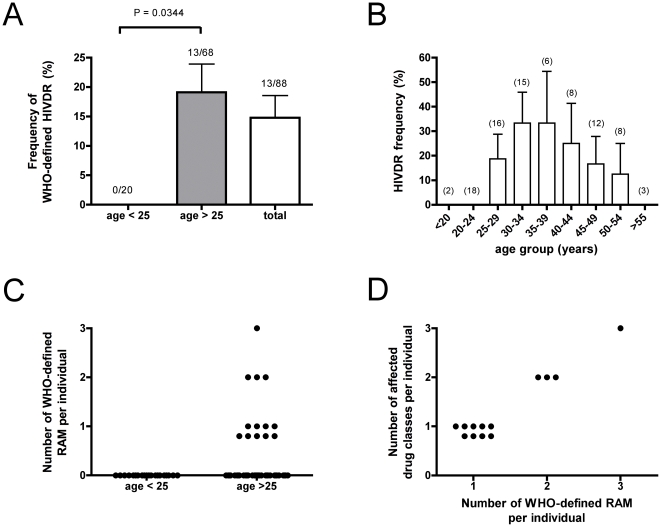
The frequency of HIVDR is age-dependent.HIVDR was determined by bulk sequencing from ART-naïve patients. A.: Frequency of WHO-defined HIVDR in patients aged under 25 years (n = 20, left bar), patients aged over 25 years (n = 68, middle bar), and in the total study population (n = 88, right white bar). B: Frequency of WHO-defined HIVDR peaks in different age groups. Numbers in brackets indicate the number of individuals tested in each age group. Data as means ± S.E.M.. For statistical analysis, Fisher's exact test was performed. Differences with a P<0.05 were regarded as statistically significant. C: Number of WHO-defined RAM per individual (“RAM burden”). D: Number of affected antiretroviral drug classes (NRTI, NNRTI, PI) per individual in relation to the number of WHO-defined RAM per individual.